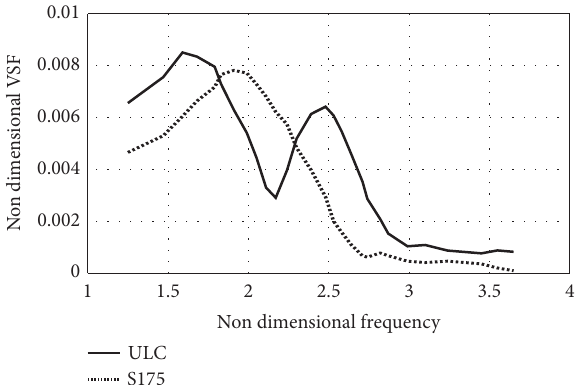
Figure 16: Shear force RAO comparison between S175 and the ULC ( F